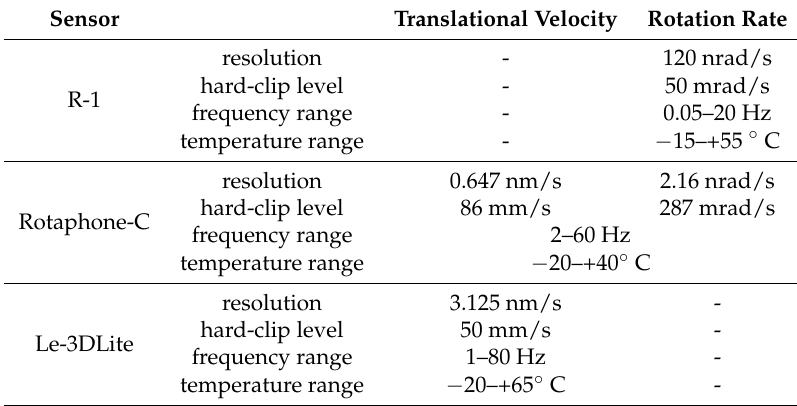
Table 1. Manufacturer specifications of the equipment involved in the experiment (only parameters relevant for the study): R-1 (top, manufacturer specification only), Rotaphone-C (middle, derived from SM-6 manufacturer specifications, A/D converter parameters and laboratory testing), and Lennartz LE-3DLite (bottom, derived from manufacturer specifications and A/D converter parameters).